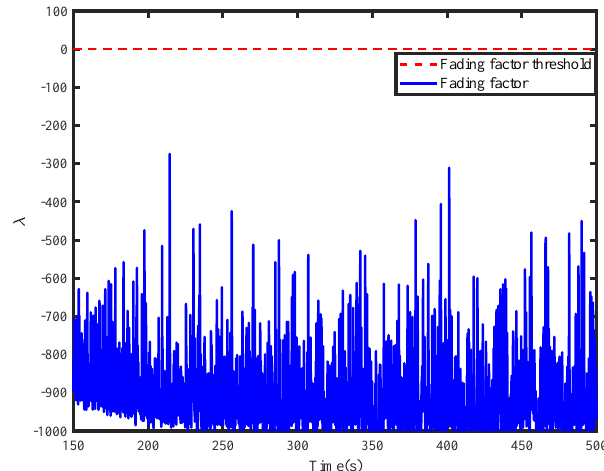
Figure 9. Fading Factors of the